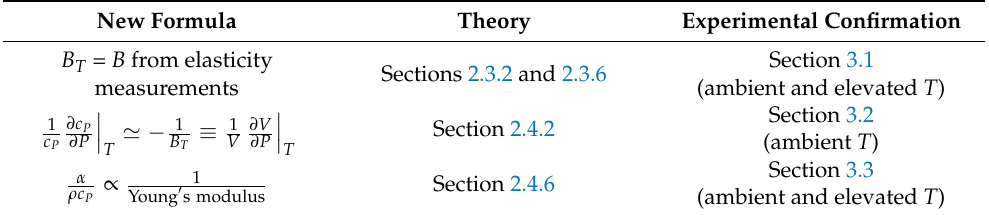
Table 1. Physical properties of perfectly frictionless elastic solids under steady-state heat